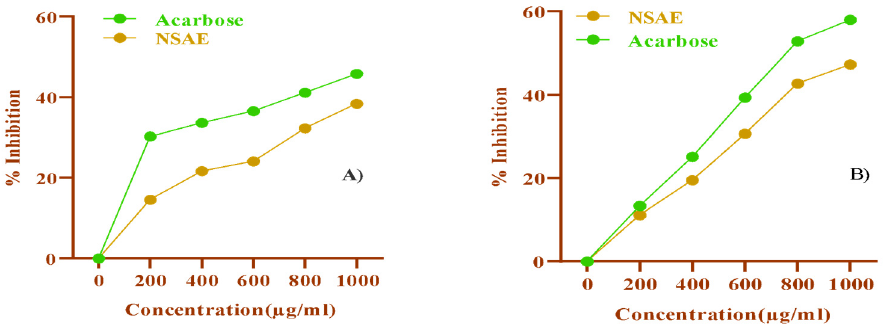
Figure 1. ( A ) α -amylase percent inhibition and ( B ) α -glucosidase percent inhibition in the presence of NSAE, utilizing acarbose as a standard (0–1000 µg/mL). The IC 50 for NSAE in the α -amylase and α -glucosidase enzyme inhibition assays were approximately 1.39 ± 0.016 mg/mL and 1.01 ± 0.022 mg/mL, respectively. Results are expressed as the mean ± SD ( n = 5) .